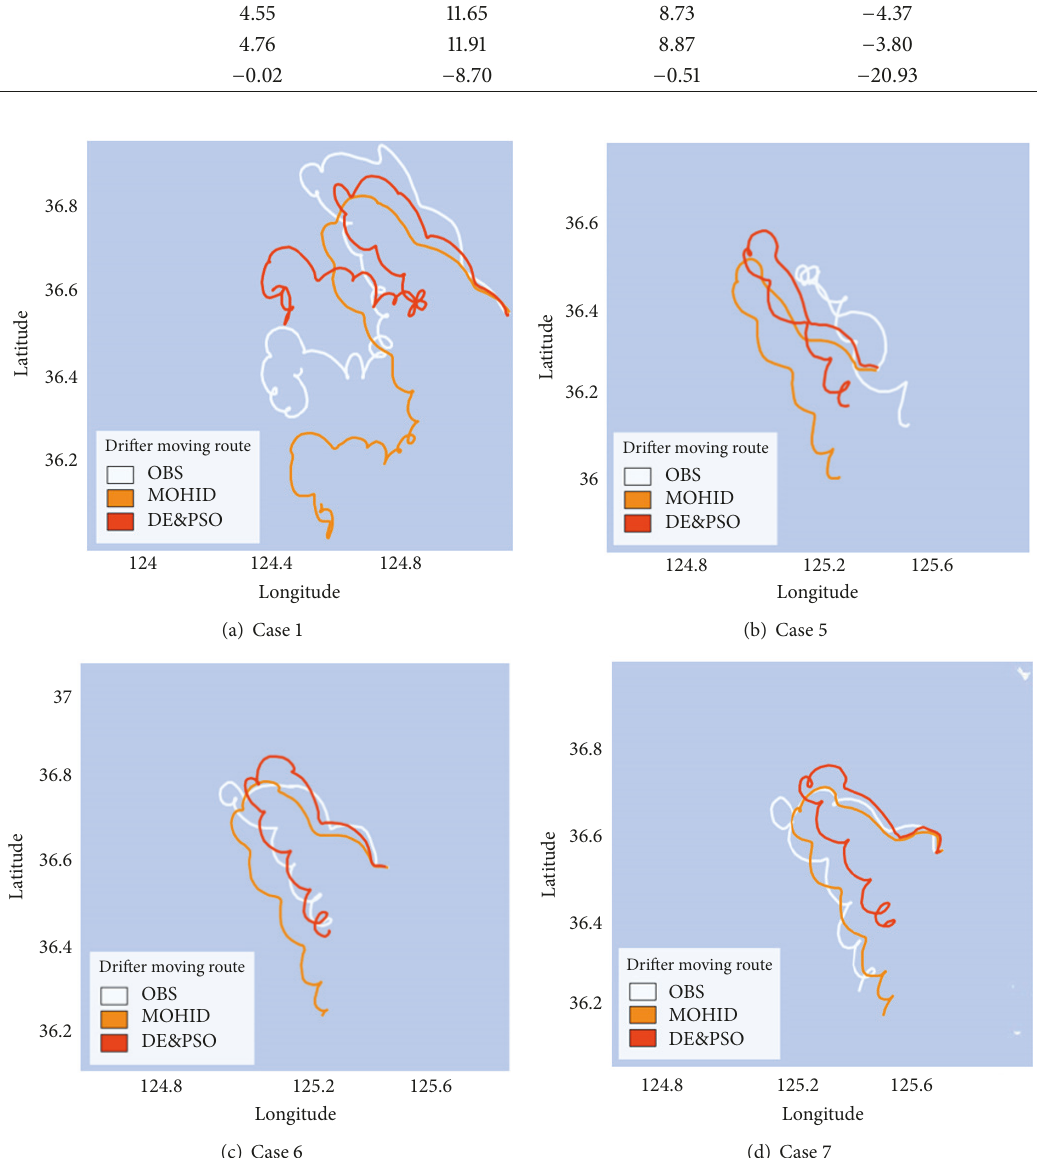
Figure 12: Comparison of predicted trajectory by our ensemble of DE&PSO, one by existing numerical model (MOHID) and observed one for four major